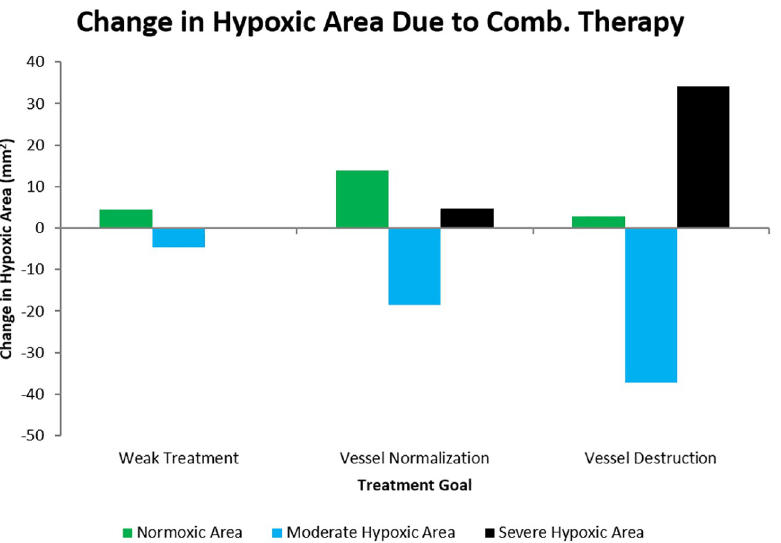
Fig 6. Cases of anti angiogenic therapy effect based on combretastatin strength. Weak treatment corresponds to an anti angiogenic strength parameter of σ = 20, vessel normalization to σ = 30, and vessel destruction to σ = 70. Normoxic area is where [ O 2 ] > 10mmHg, moderate hypoxic where 5 < [ O 2 ] < 10mmHg, and severe hypoxic where [ O 2 ] < 5mmHg. The hypoxic ranges were chosen from the understood ranges of tumour hypoxia ([7, 25] for example). Combretastatin is given every other day starting on the 15th day in decreasing amounts (of magnitudes 1, 0.75, 0.5, 0.25, and 0.1). Notice that there is an optimal middle strength where the increase in normoxic area is maximized.